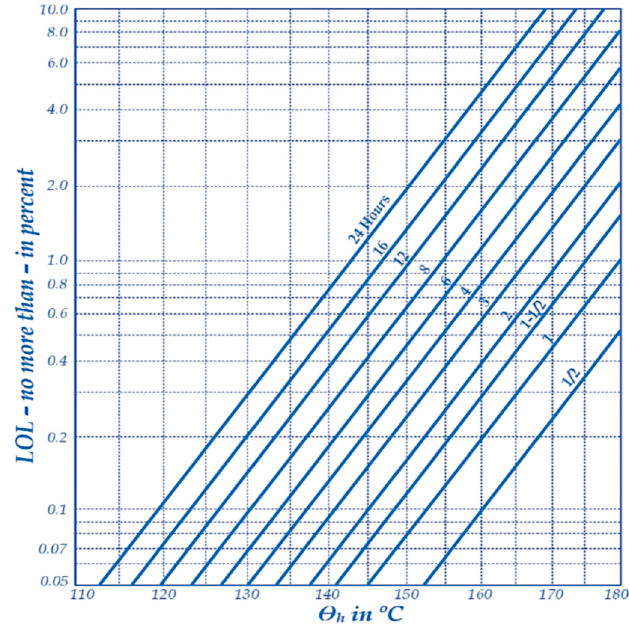
Figure 4. LOL and θ h in different time [25].